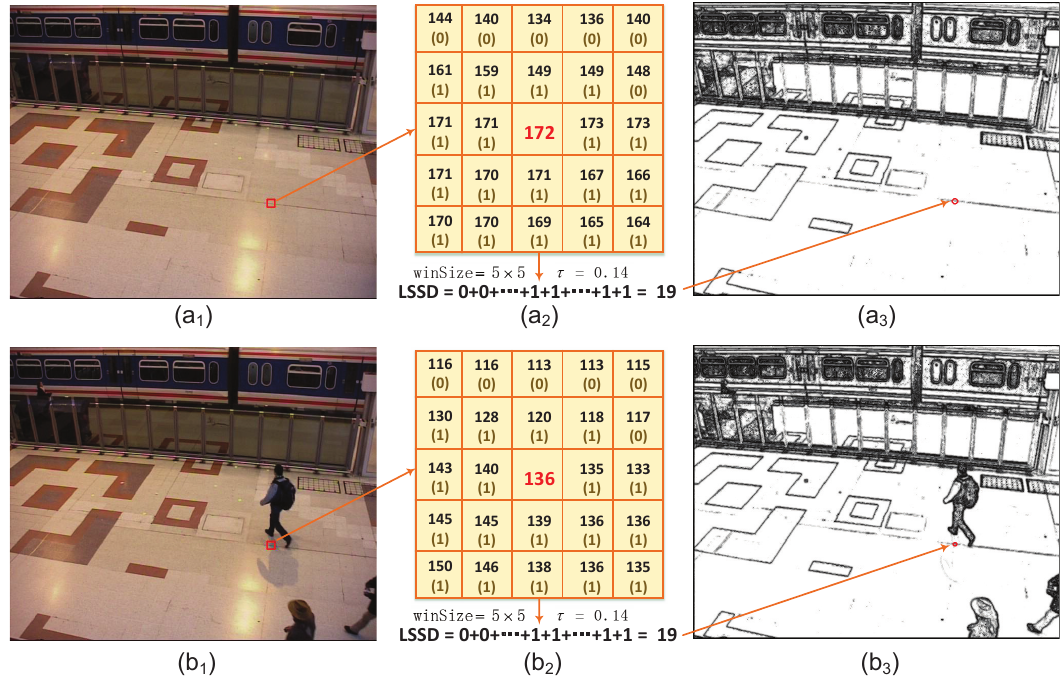
Figure 3. An LSSD encoding example under illumination changes. First column: input images. Second column: the intensity values of the small red box in the input images. Third column: the corresponding LSSD feature